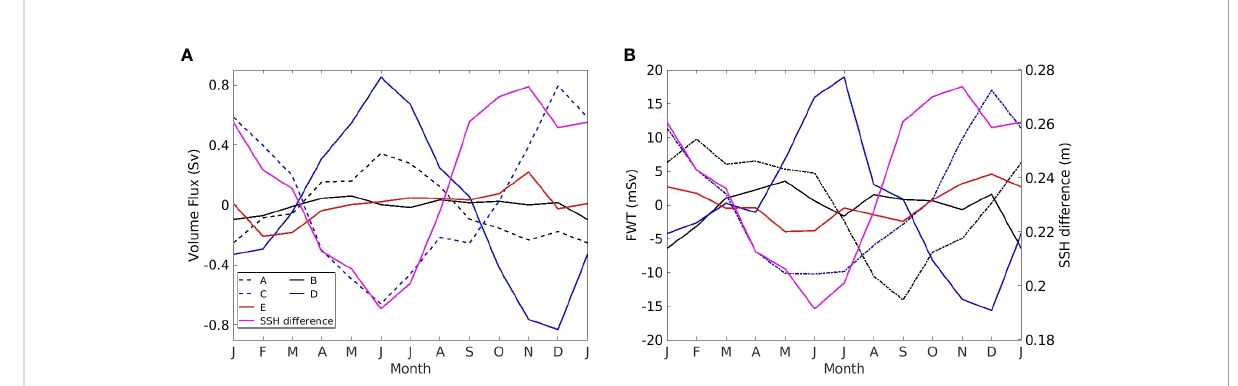
FIGURE 9 Seasonal variations of the (A) volume fl ux and (B) FWT through the 5 sections, and the result by subtracting the SSH value at (47°W, 47°N) from that at (50°W, 47°N), then taking the average for the same calendar month over 1993- 2018. The positive directions of the seasonal variations of the volume fl ux and FWT for each section are (A): northward; (B): westward; (C): westward; (D): eastward, and (E): eastward. The two locations for calculating the SSH difference are shown in Figure 1.